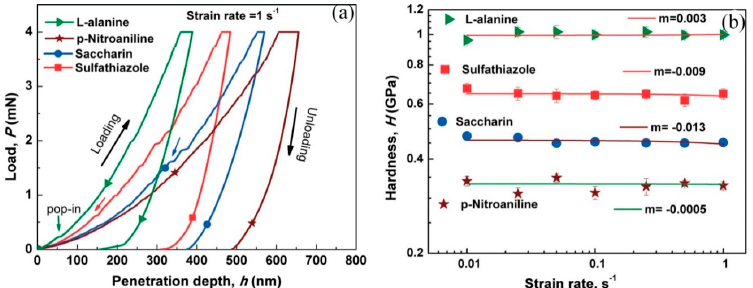
Figure 15. ( a ) Representative P-h curves obtained using Berkovich nanoindentation on the major faces of different organic molecular single crystals at a strain rate of (cid:2013)(cid:4662) = 1 s − 1 , and ( b ) the m values obtained